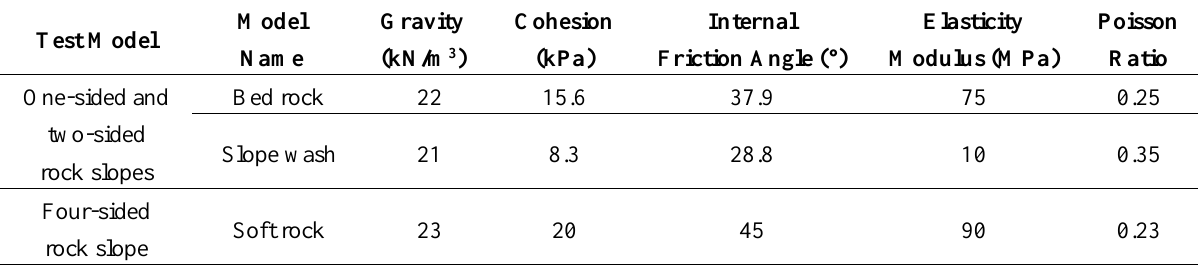
Table 1. Mechanics parameters of slide mass and slide bed and constitutive model.